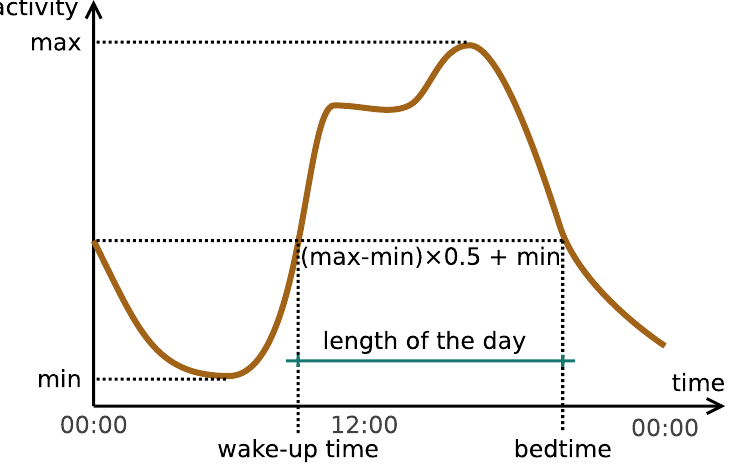
Figure 7. Calculation of the wake-up time and the